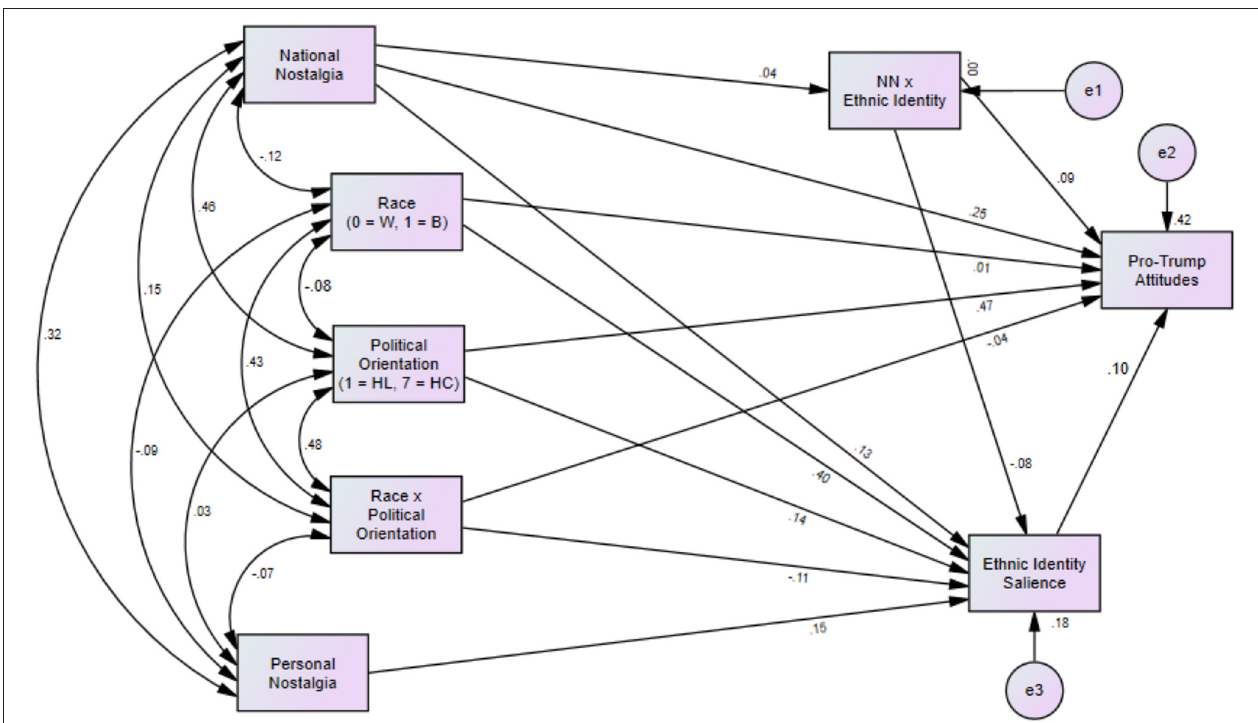
FIGURE 4 | Path analysis estimating interaction effects (race × political orientation and ethnic identity × nostalgia) on pro-Trump attitudes. Note. Path coefficients represent standardized